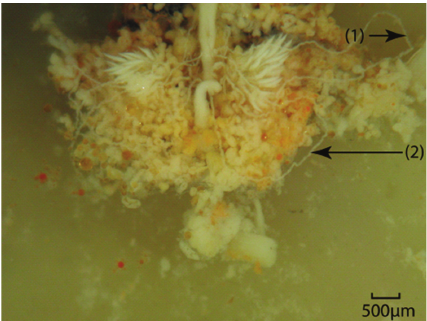
Figure 2: Photomicrograph of “stage 2” dissection of C. septem- punctata detailing the abdominal portion of the alimentary tract. Two complete malpighian tubules (1) and (2) were physically unfolded for improved examination.